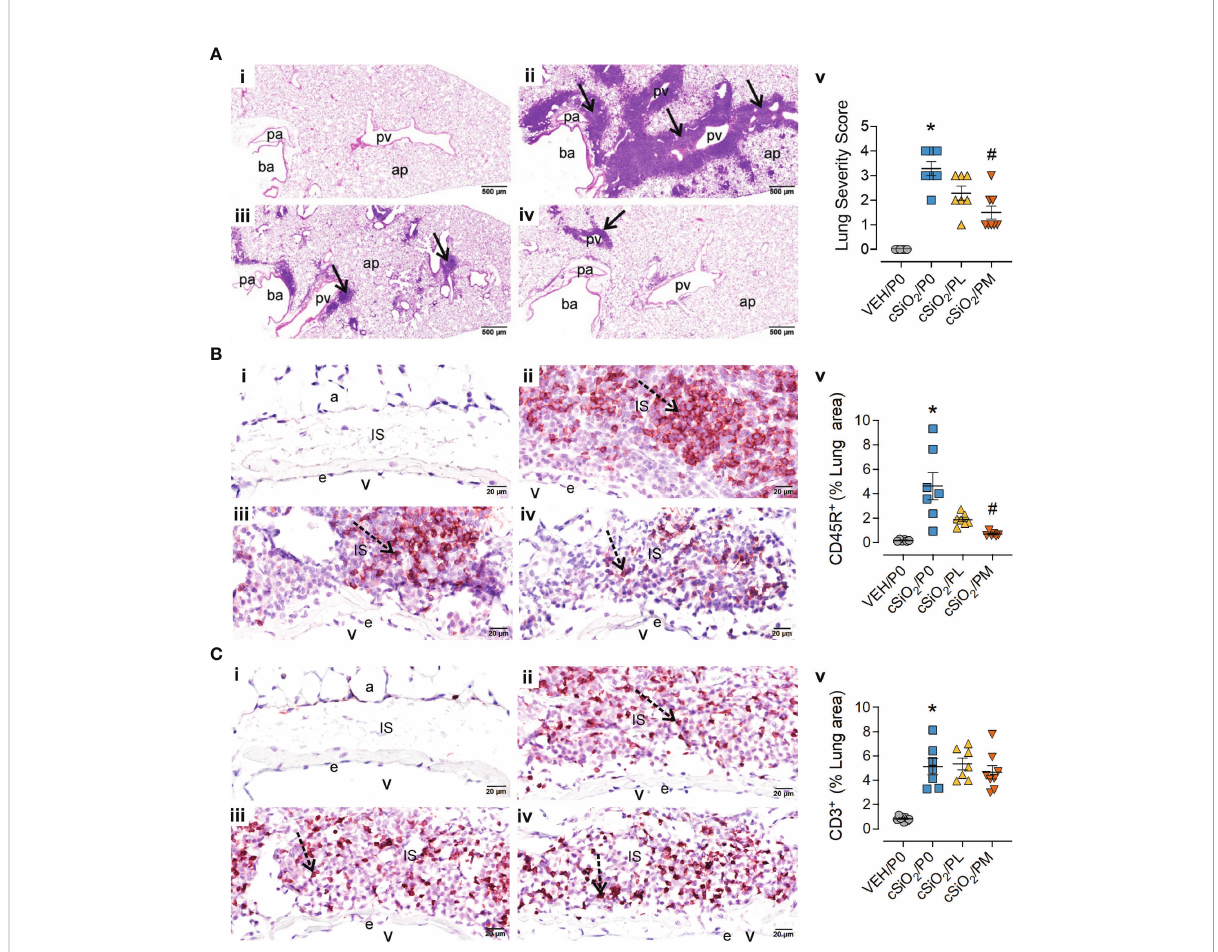
FIGURE 3 Moderate dose prednisone (PM) signi fi cantly reduced pulmonary peribronchiolar and perivascular formation of Ectopic Lymphoid Structures (ELS) and in fi ltration of perivascular CD45R+ B cells, but not CD3+ T cells. Light photomicrographs of hematoxylin and eosin-stained lung tissue sections (A) from (i) VEH/P0, (ii) cSiO 2 /P0, (iii) cSiO 2 /PL, and (iv) cSiO 2 /PM mice. cSiO 2 treatment resulted in formation of ELS in peribronchiolar and perivascular interstitium (A.ii). Graphic representation of semi-quantitative severity scores following assessment criteria of (1) minimal (<10% of lung tissue affected); (2) slight (10-25%); (3) moderated (26-50%), (4) marked (51-75%), (5) severe (>75%) of total area affected (A.v). PM, but not PL, signi fi cantly reduced the amount of ELS (A.iii-v). pa, pulmonary artery; ba, bronchiolar airway; pv, pulmonary vein; alveolar parenchyma; arrows, peri-vascular/bronchiolar ectopic lymphoid structures. Photomicrographs of lung tissue immunohistochemically stained for (B) CD45R+ B lymphoid cells and (C) CD3+ T cells in lungs from (i) VEH/P0, (ii) cSiO 2 /P0, (iii) cSiO 2 /PL, and (iv) cSiO 2 /PM mice. e, endothelium; v, venous lumen; IS, perivascular interstitial space; a, alveolus. cSiO2 treatment signi fi cantly triggered interstitial in fi ltration of CD45R+ B cells (B.ii) and CD3+ T cells (C.ii). PM treatment signi fi cantly reduced CD45R+ B cell in fi ltration (B.iv) but had no effect on CD3+ T cells (C.iii-iv). Graphical representation of morphometrically determined density of CD45R+ B cells (B.v), and CD3+ T cells (C.v) in lung tissue. *Indicates p<0.05 for VEH/P0 vs cSiO 2 /P0; # indicates p<0.05 for cSiO 2 /P0 vs cSiO 2 /PL or cSiO 2 /PM